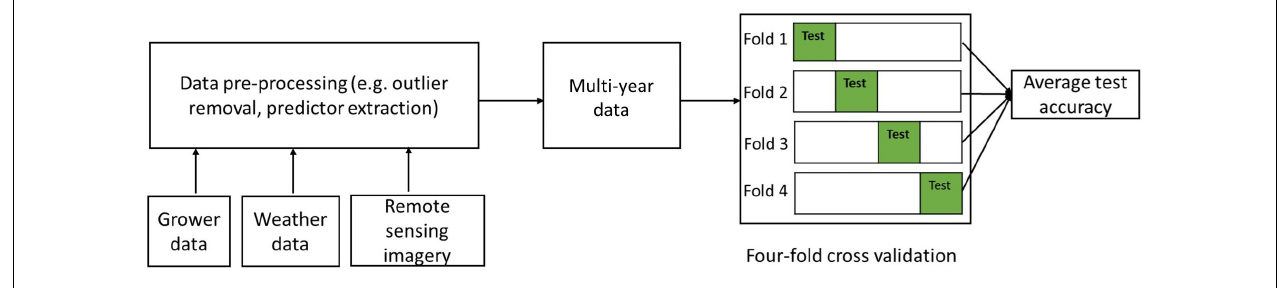
FIGURE 3 | Flowchart of the four-fold cross validation modeling